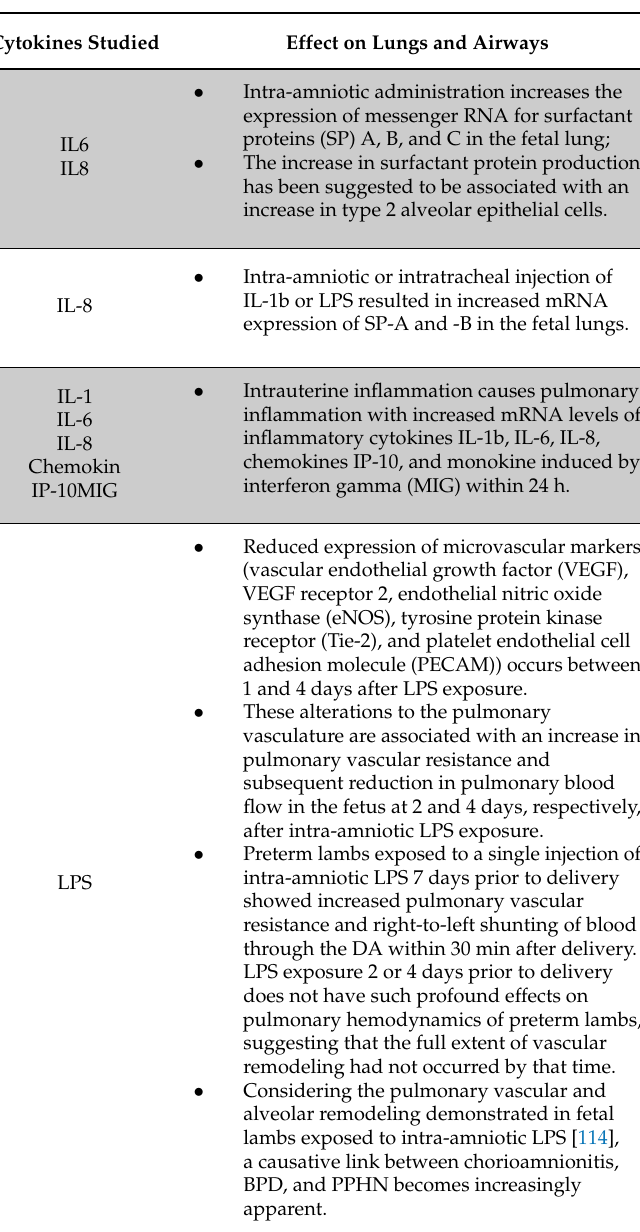
Table 2 summarizes the effects of pro-inflammatory cytokines and consequent inflam- mation on lungs and peripheral airways. Table 2. Effects of proinflammatory cytokines and LPS-induced inflammation on lungs and airways. Abbreviations as used in the